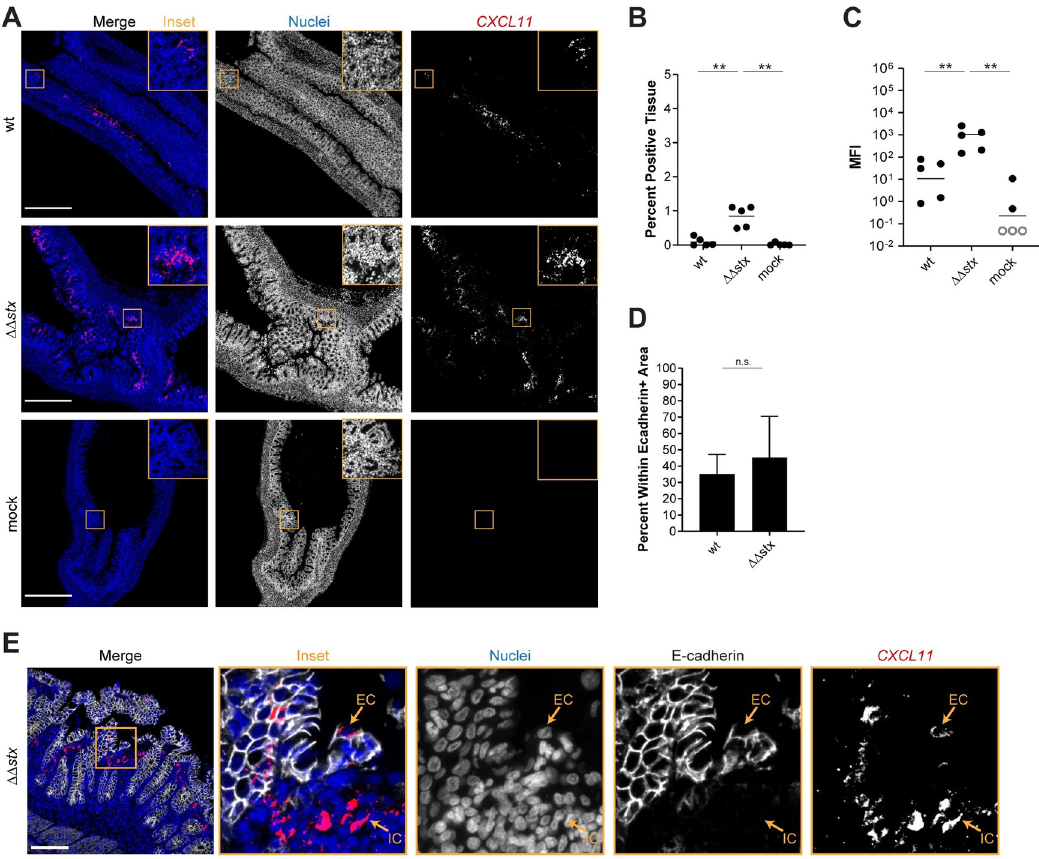
Fig 6. Expression of CXCL11 in is greater in animals infected with ΔΔ stx vs WT EHEC. (A) Micrographs of colon sections from rabbits inoculated with WT EHEC, ΔΔ stx EHEC, or PBS (mock) stained with a probe to rabbit CXCL11 mRNA (red) and DAPI (blue). Scale bar is 500 μ M. (B) Percentage of tissue section with CXCL11 signal from individual colons. Distributions compared using Mann-Whitney U test, p < 0.01 ( �� ), n.s. indicates not significant. (C) Mean fluorescent intensity (MFI) from individual colons plotted with mean. Distributions compared using Mann-Whitney U test, p < 0.01 ( �� ), n.s. indicates not significant. (D) Percent CXCL11 signal within E-cadherin positive cells. Distributions compared using the Mann-Whitney U test, p < 0.05 ( � ). (E) Sections stained with a probe to rabbit CXCL11 mRNA (red), DAPI (blue), and anti-E-cadherin antibody (white). Scale bar is 500 μ M. Example immune cell (IC) and epithelial cell (EC) is